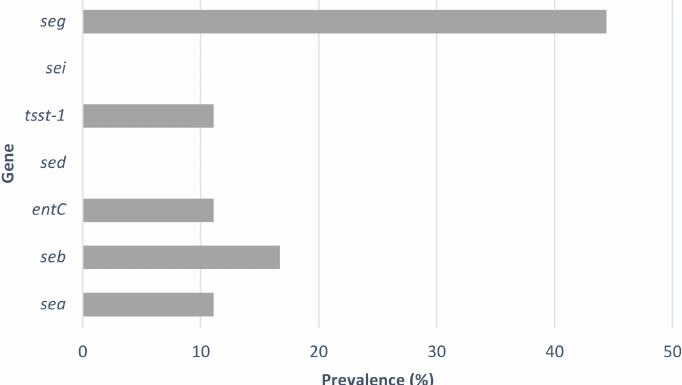
Figure 1. Prevalence of toxin genes in the S. aureus